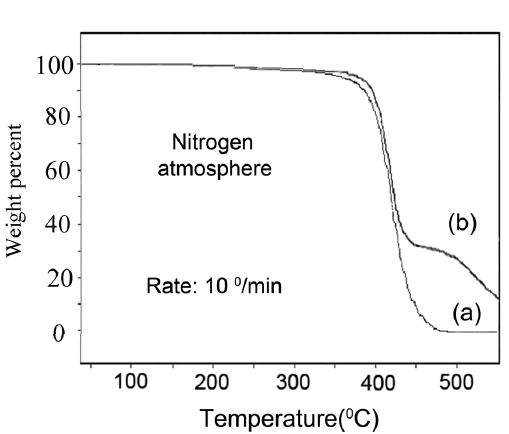
Figure 12. TGA curves of (a) pure ABS, (b) ABS/Sb 2 O 3 - Br compound.